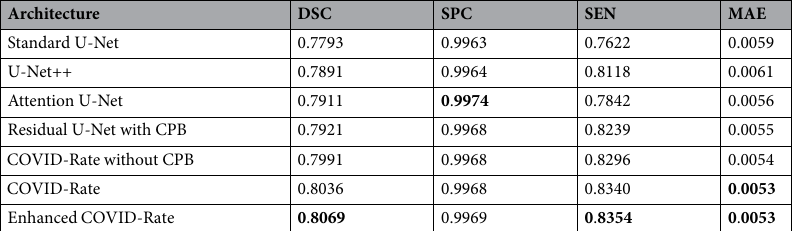
Table 4. Quantitative comparison of different architectures in segmenting COVID-19 lesions. The presented results are the average of the obtained results through a 10-fold cross-validation process. The best results have been highlighted in